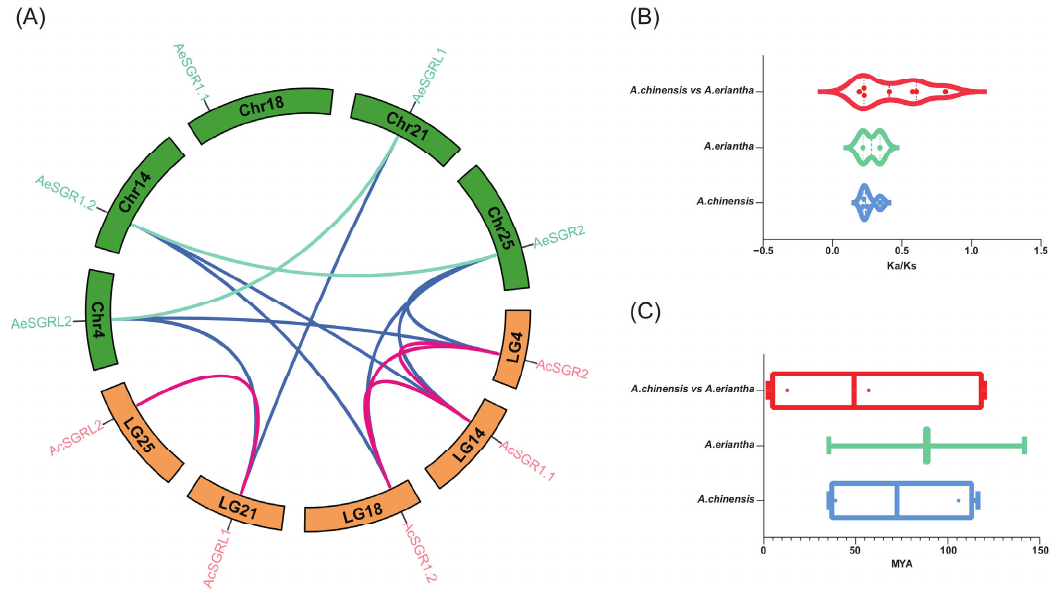
Figure 4. Collinearity analysis of kiwifruit SGRs . ( A ) The syntenic gene pairs were connected by lines with different colors. The orange and green bars indicated chromosomes for Ac and Ae, respectively. Red lines represented the synteny relationship in Ac; Green lines represented the synteny relationship in Ae; Blue lines represented syntenic gene pairs in Ac and Ae. ( B ) Ka/Ks ratio, and ( C ) divergence time of syntenic gene pairs.